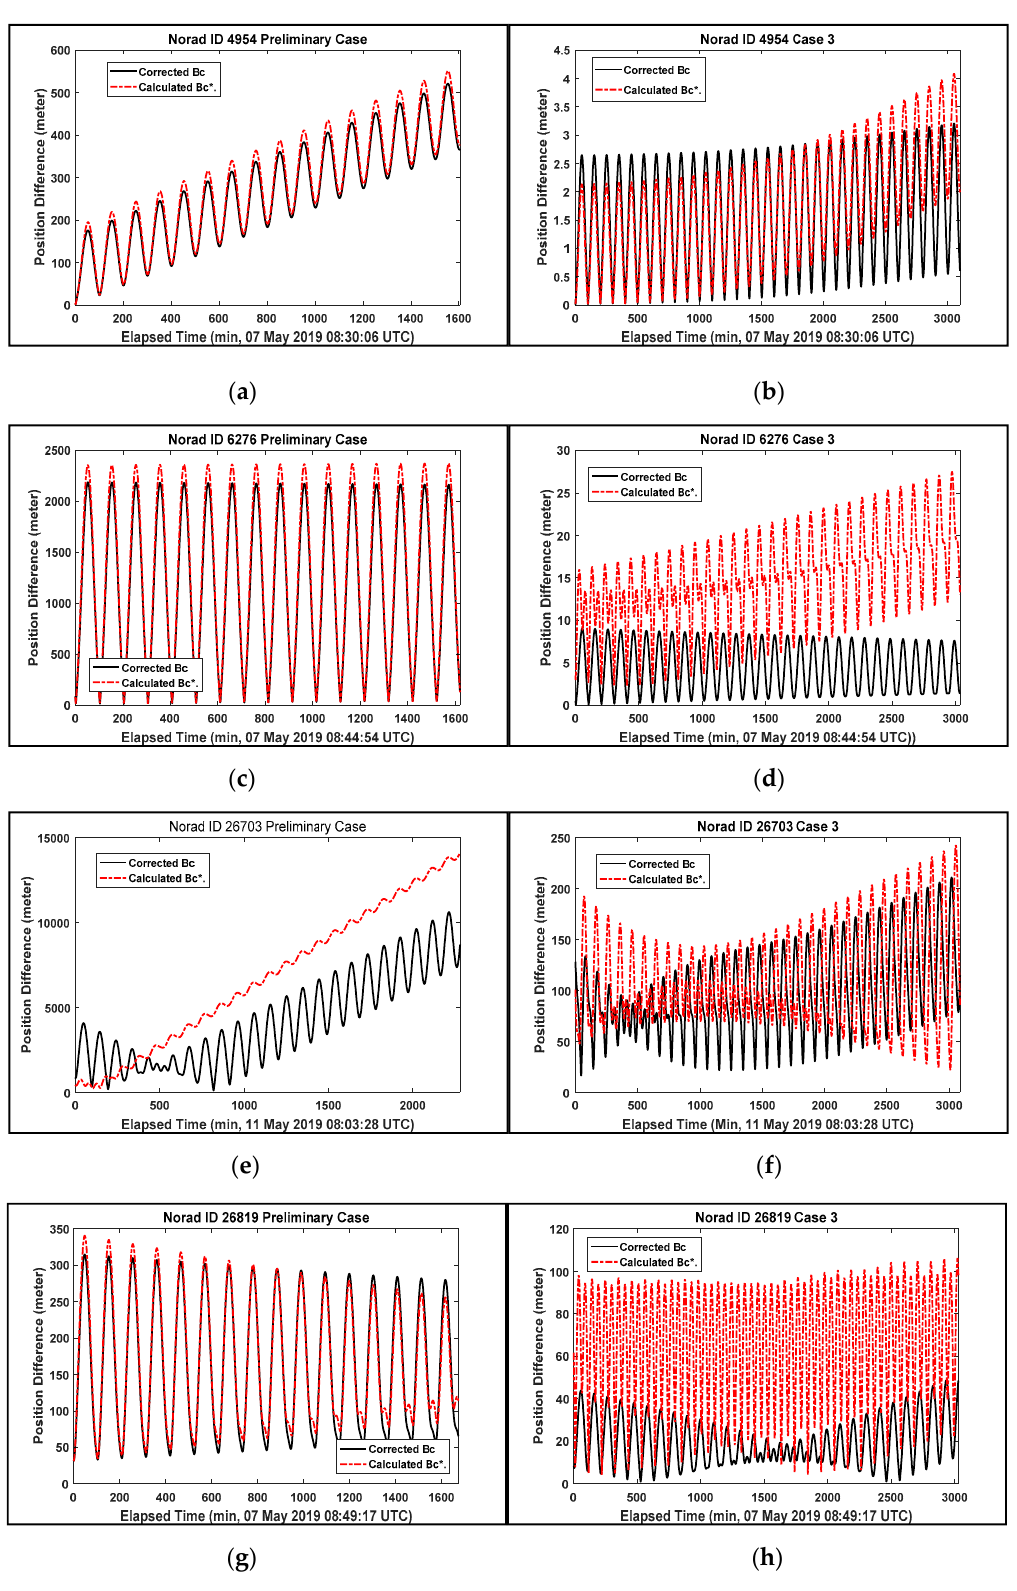
Figure 8. The position difference of the corrected 𝑩 𝑪 and calculated 𝑩 𝒄∗ application. ( a ) ID 4954, preliminary Case; ( b ) ID 4954, Case 3; ( c ) ID 6276, preliminary Case; ( d ) ID 6276, Case 3; ( e ) ID 26703, preliminary Case; ( f ) ID 26703, Case 3; ( g ) ID 26819, preliminary Case; ( h ) ID 26819, Case 3. Table 10 . The 3D position difference RMS of preliminary case and Case 3.